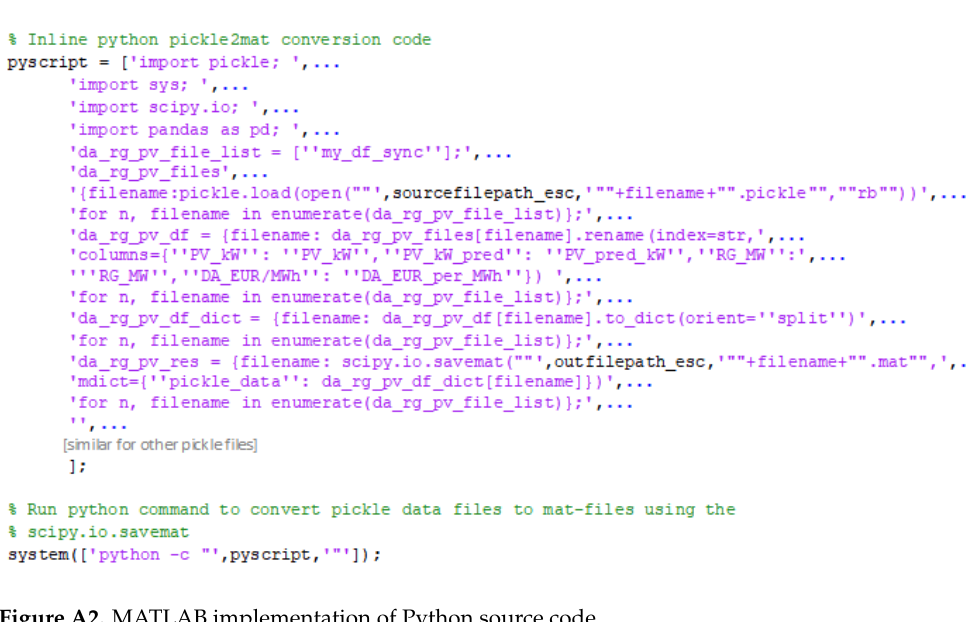
Figure A2. MATLAB implementation of Python source